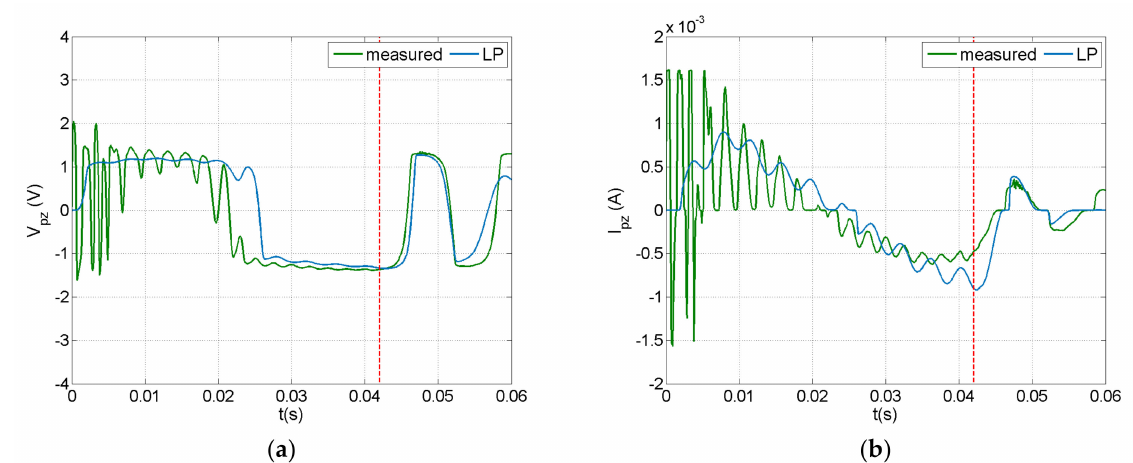
Figure 9. Predicted and measured signals at the piezoelectric terminals of the PEH circuit with a 100 µ F capacitor in the case of impact: ( a ) voltage, ( b ) current.